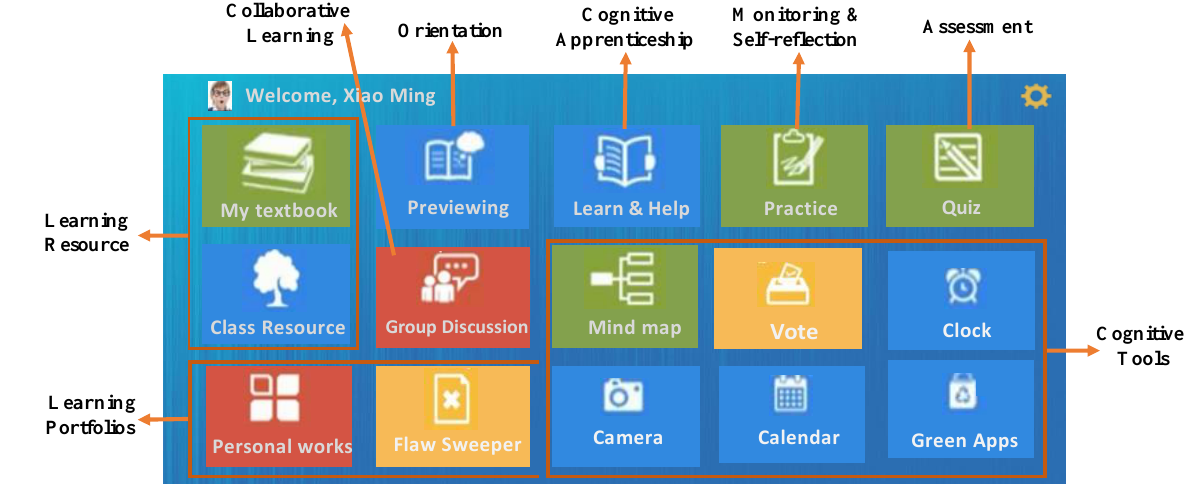
Figure 1 The interface of the one-to-one computing